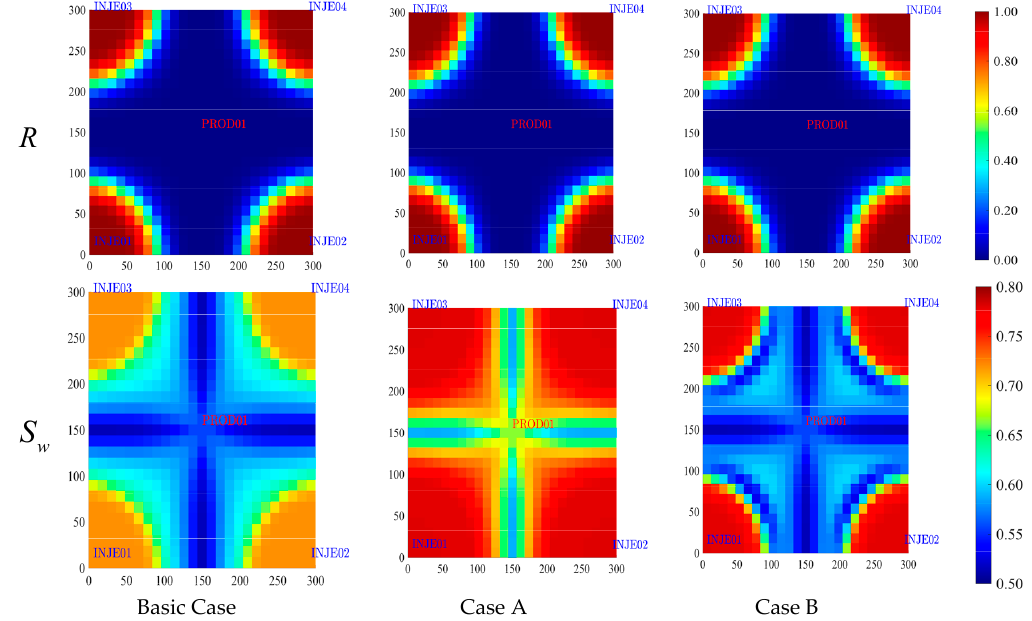
Figure 8. Water saturation distribution in the polymer flooding (Time step = 12.08 years).